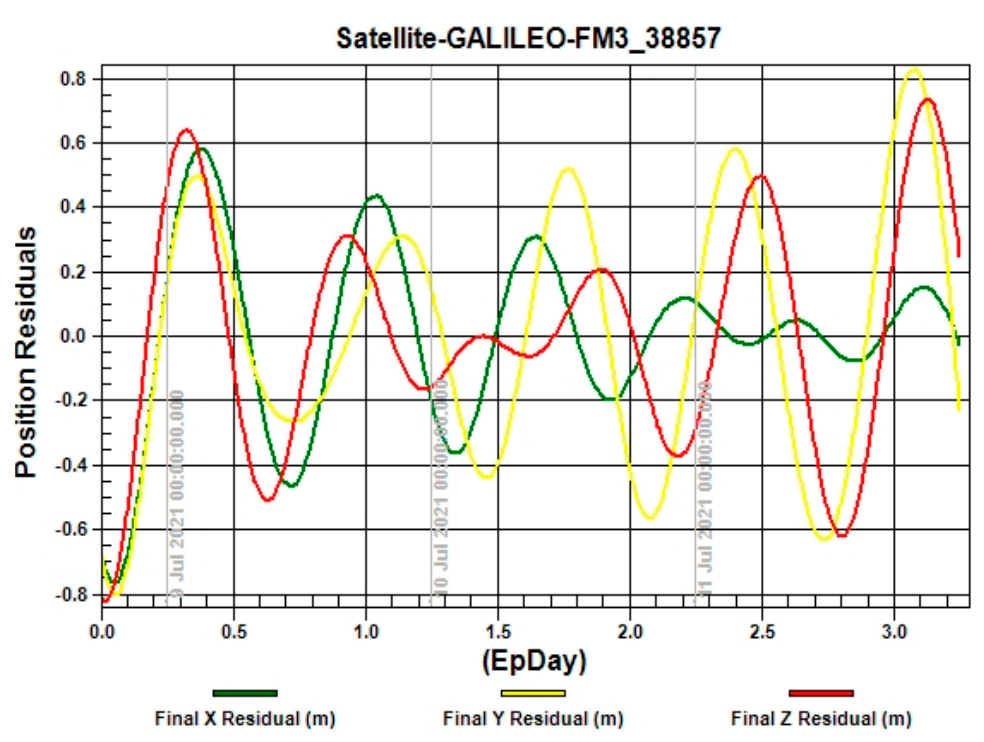
Figure 7. The relationship between the position residuals and the time for satellite “COSMOS-2501”.